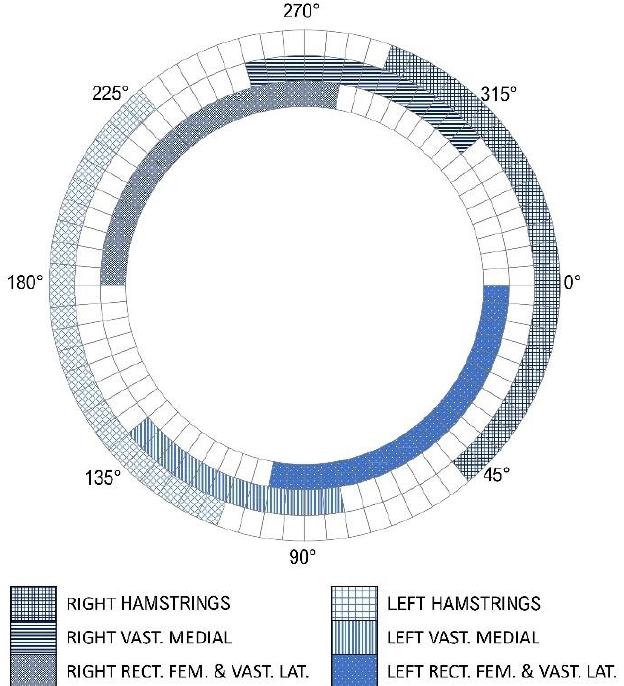
Figure 7. Final stimulation profiles showing the start and end angles for each muscle within a pedaling cycle. Right and left hamstrings (HAM) are shown as the blue grids; right and left vastus medialis (VM) as the horizontal and vertical blue lines, respectively; and vastus lateralis and rectus femoris (VL + RF) as the dotted squares. Zero angle is when the crank arm is positioned horizontally, and the right leg extended.